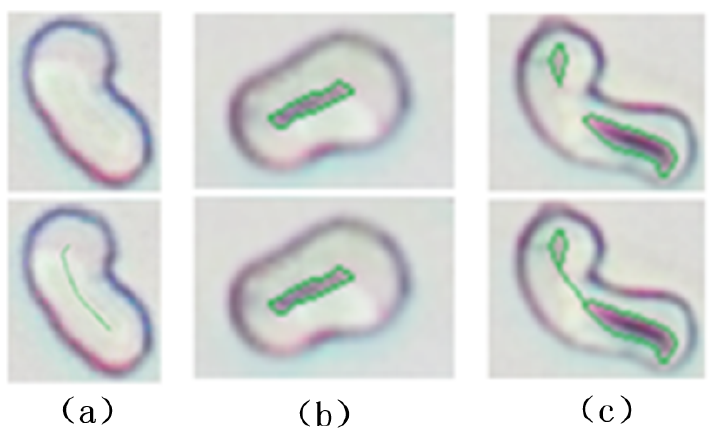
Figure 3. Processing of inner edge of cross-section.( a ) Cross-section without inner edge. ( b ) Normal cross-section. ( c ) Cross-section with multiple fragments of the inner